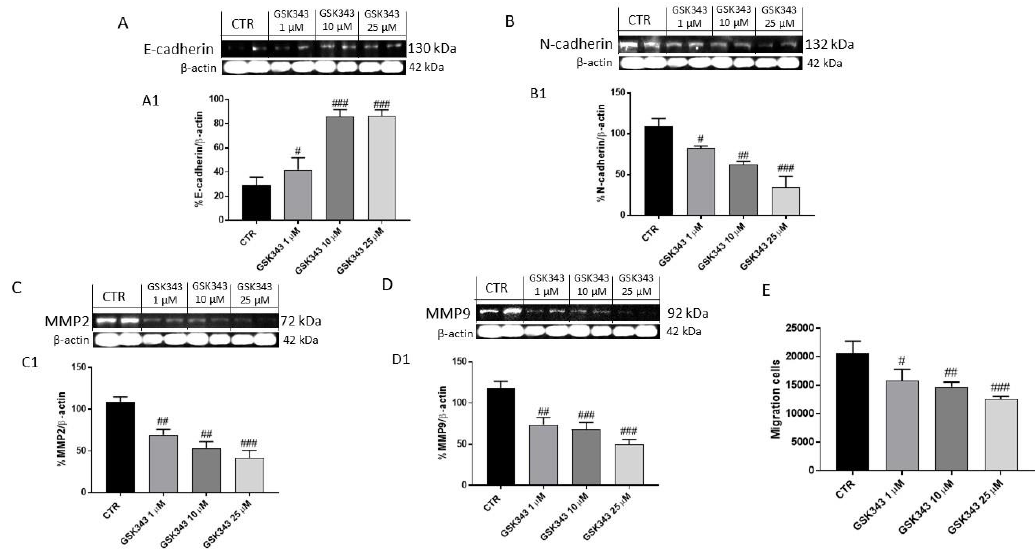
Figure 4. Effect of GSK343 treatment on E-cadherin, N-cadherin, MMP2 and MMP9 expression in U87 cell lysates. The treatment with GSK343 at the concentrations of 1, 10 and 25 µ M increased E-cadherin and reduced N-cadherin expression compared to control group ( A , B ). Moreover, the treatment with GSK343 at the concentrations of 1, 10 and 25 µ M significantly reduced MMP2, and MMP9 expression( C , D ). The treatment withGSK343decreasedalsoU87cellsmigration( E ).Dataarerepresentativeofatleastthreeindependentexper- iments. ( A ) # p < 0.05 vs. Ctr; ### p < 0.001 vs. Ctr; ( B ) # p < 0.05 vs. Ctr; ## p < 0.01 vs. Ctr; ### p < 0.001 vs. Ctr. ( C ) ## p < 0.01 vs. Ctr; ### p < 0.001 vs. Ctr; ( D ) ## p < 0.01 vs. Ctr; ### p < 0.001 vs.